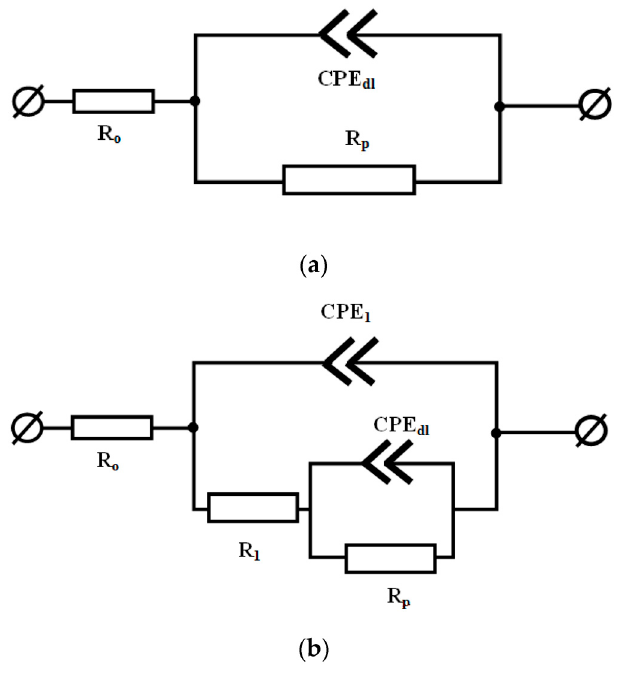
Figure 11. Equivalent circuits used to fit impedance data. For non-modified steel ( a ) and steel pre-modified with organosilanes solutions ( b